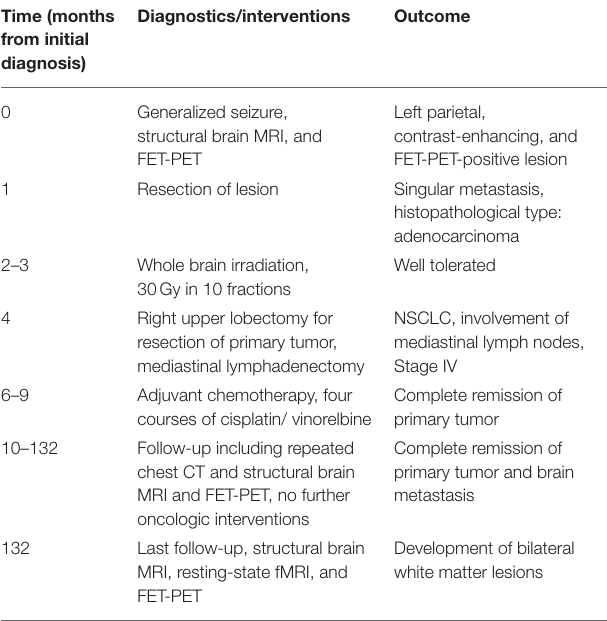
TABLE 1 | Timeline of diagnostics and therapeutic